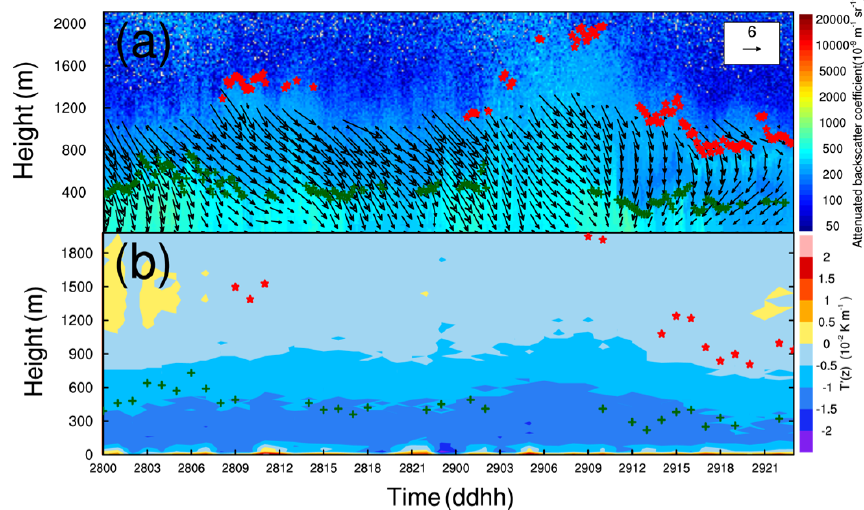
Figure 11. Attenuated backscatter coefficient (shaded; units: 10 − 9 m − 1 sr − 1 ) measured by a ceilometer and horizontal winds (vectors; units: ms − 1 ) measured by lidar (a) ; gradient of temperature T (cid:48) (z) (shaded; units: Kkm − 1 ) measured by an MWR (b) for type A. The green crosses and red stars represent the low and top PBLH, respectively.